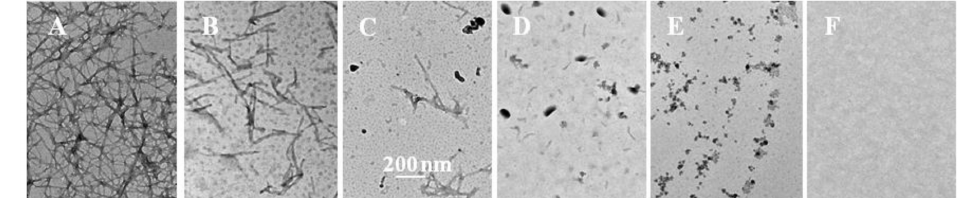
Figure 5. TEM images of insulin assemblies. Samples were prepared via the incubation of insulin (0.1 mM) at 60 ◦ C for 12 h in the absence ( A ) and presence of 0.4 mM AsA ( B ), AsA48h ( C ), DHA ( D ), and DKG ( E ). Insulin (0.1 mM) before incubation is shown in ( F ). Scale bar represents 200 nm.